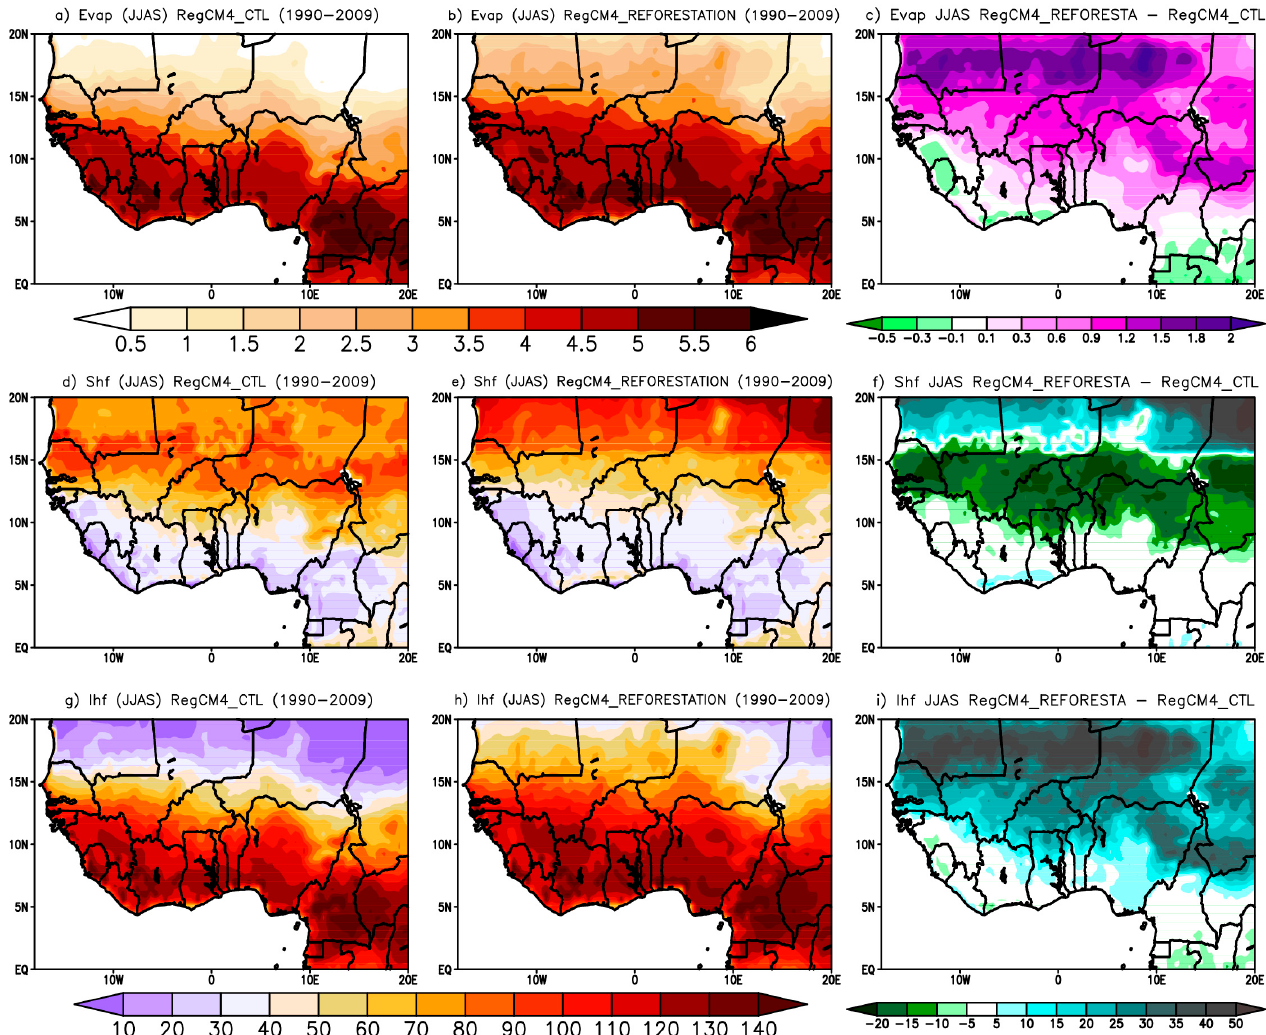
Figure 3. ( a – c ) Evapotranspiration (Evap) expressed in cg/m 2 /s, ( d – f ) sensible heat flux (Shf) and ( g – i ) latent heat flux (lhf) expressed in W · m − 2 during the JJAS period averaged from 1990 to 2009 over West Africa for RegCM4_CTL; RegCM4_REFORESTATION and